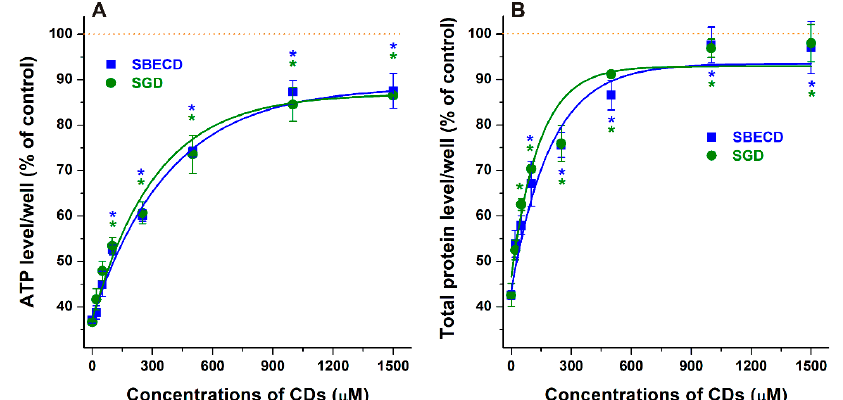
Figure 4. Co-treatment of SH-SY5Y cells with CPZ (20 µM) and CDs (0, 20, 50, 100, 250, 500, 1000, and 1500 µM) for 24 h: SBECD and SGD strongly alleviated the CPZ-induced loss in cell viability based on both cellular ATP ( A ) and total protein ( B ) levels. Means ± SEM values are demonstrated ( n = 3, * p < 0.01; see further experimental details in Section 2.2).